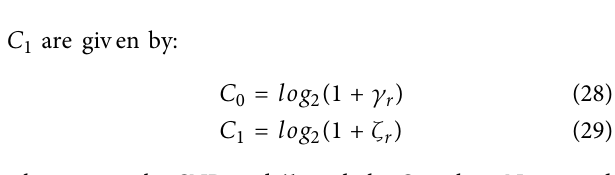
) and Transmission sub-period ( T s